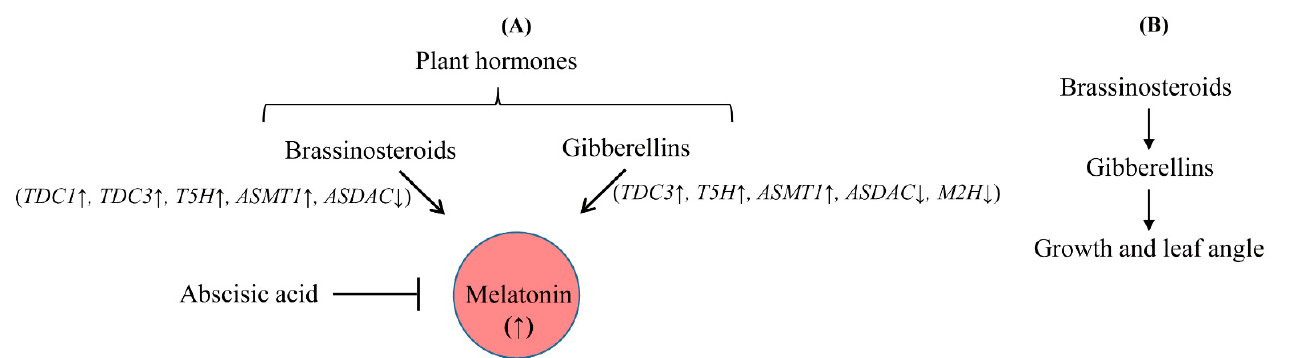
Figure 9. Proposed model for melatonin biosynthesis by endogenous hormones. ( A ) Brassinosteroids (BR)-induced melatonin increase in a gibberellins (GA)-independent manner and ( B ) BR-induced GA-dependent regulation of growth and leaf angle. GA and BR induce melatonin production independently, whereas abscisic acid inhibits melatonin production. The induction patterns of genes responsible for melatonin biosynthesis and metabolism were slightly different between hormone treatments. BR treatment induced several genes involved in melatonin biosynthesis, including TDC1 , TDC3 , T5H , and ASMT1 , whereas GA induced TDC3 , T5H , and ASMT1 . ASDAC and M2H were downregulated by GA treatment, while only ASDAC was downregulated by BR treatment. Unlike BR and GA, abscisic acid inhibits melatonin synthesis [20].